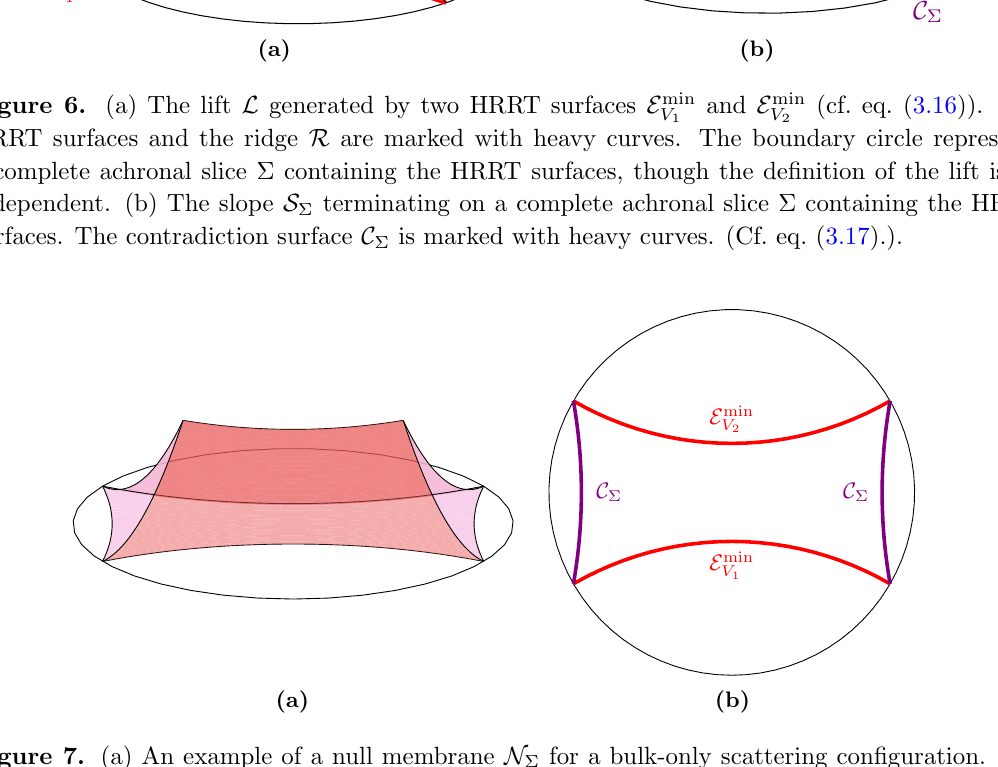
Figure 7. (a) An example of a null membrane N (cid:6) for a bulk-only scattering con(cid:12)guration. The null membrane generically has a spacelike ridge as its future boundary and four spacelike seams where the lift and slope meet; more on this in (cid:12)gure 8. (b) The past boundary of N (cid:6) is topologically S 1 on any complete achronal slice containing the HRRT surfaces of V 1 and V 2